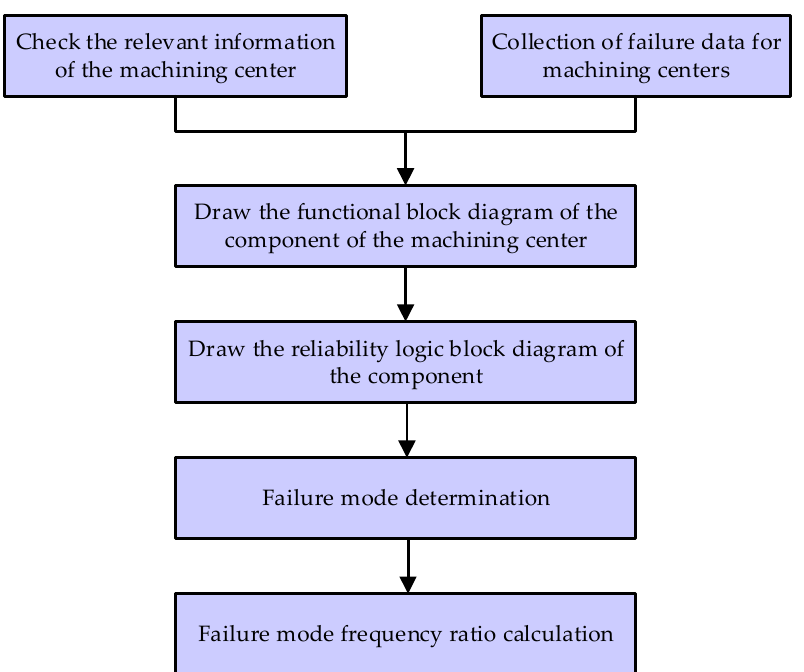
Figure 2. Block diagram of the calculation of the failure mode frequency ratio of the machining center.